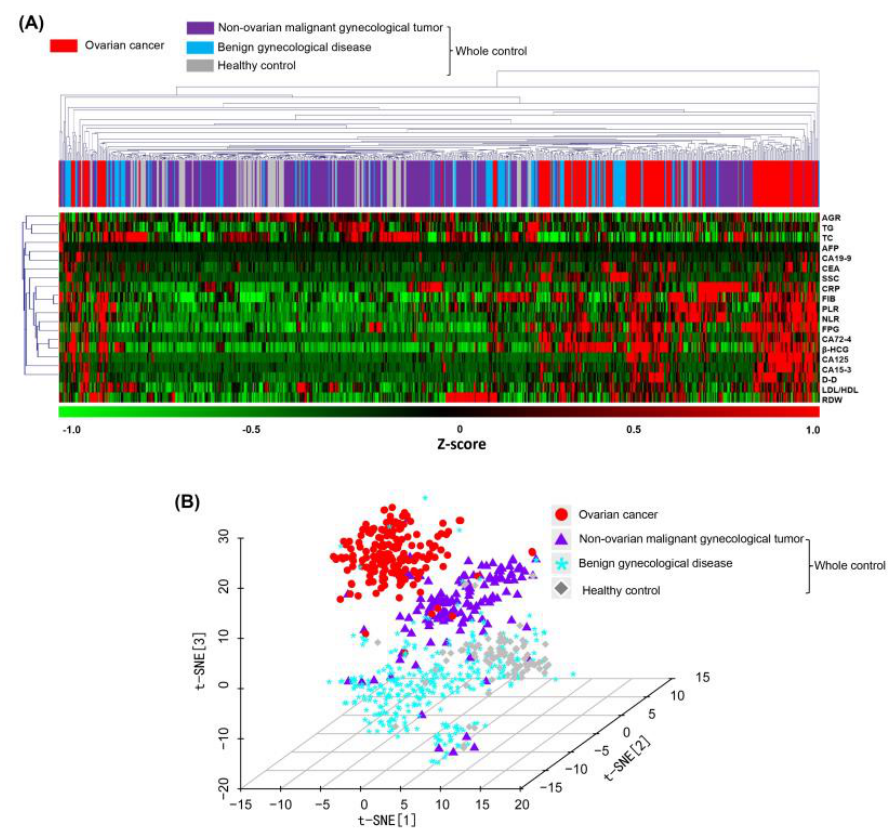
Figure 2. Demonstration of the differentiation effect of unsupervised clustering (four different colors represent ovarian cancer and three control subgroups). ( A ) Heat map of the differences in laboratory index levels with the spectral map of systematic clustering. AGR, albumin-to-globulin ratio; TG, triglycerides; TC, total cholesterol; AFP, alpha-fetoprotein; SCC, squamous cell carcinoma- associated antigen; CRP, C-reactive protein; FIB, fibrinogen; PLR, platelet-to-lymphocyte ratio; NLR, neutrophil-to-lymphocyte ratio; FBG, fasting blood glucose; D-D, D-dimer quantification; RDW, red blood cell distribution width. ( B ) Sample distribution in the space composed of three t-distribution random-domain embedding